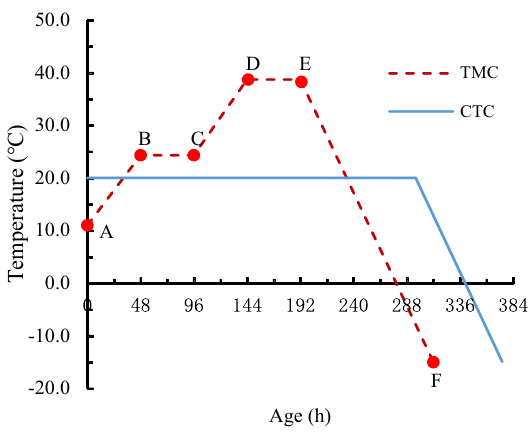
Figure 3: Measured temperature curves of the three concretes under TMC mode.